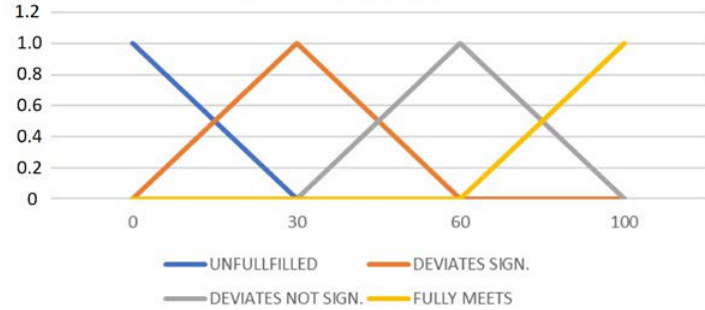
Figure 13. Graphical representation membership functions for linguistic variables for Software